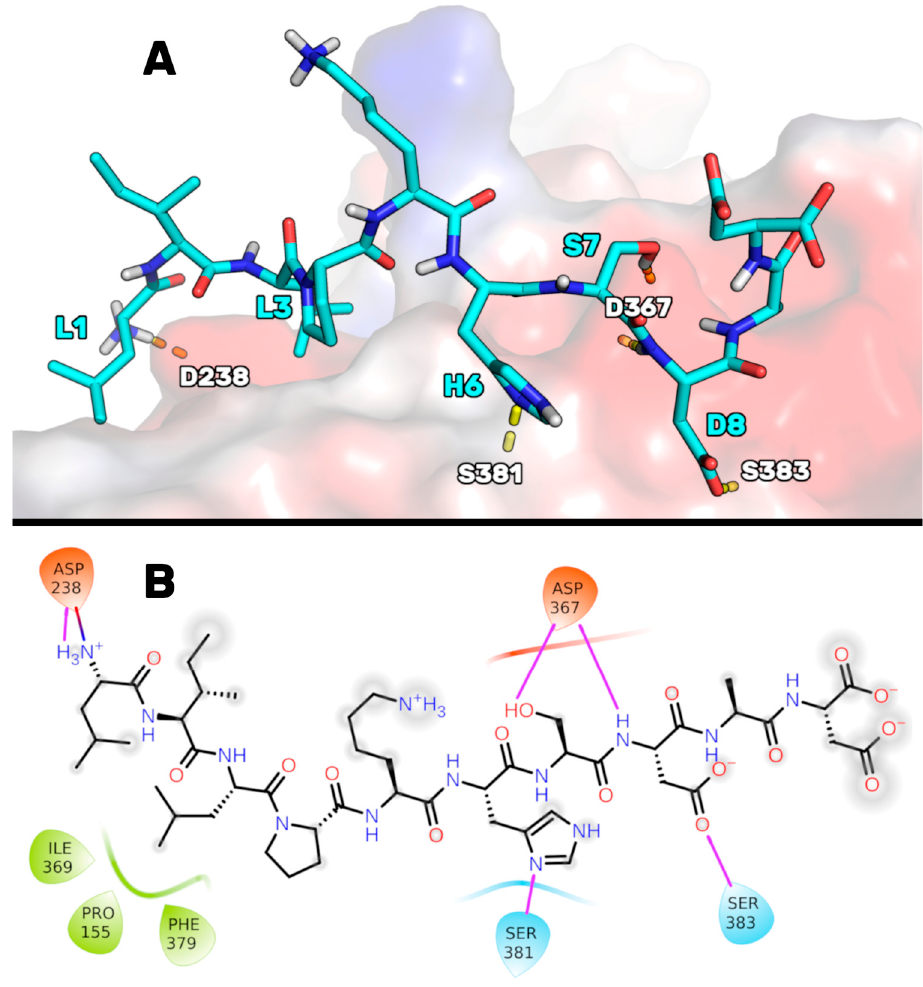
Figure 1. ( A ) The expected P5 binding mode on the PCSK9 surface after additional MD simulations. Yellow dotted lines highlight the H-bond network. The enzyme solvent-accessible surface is depicted accordingly by the partial charge of the residues: blue for positive areas and red for negative areas. Peptide P5 is represented as cyan sticks. ( B ) 2D representation of the predicted P5 binding mode in complex with PCSK9. H-bonds and salt bridges are highlighted in purple and blue/red lines, respectively. Hydrophobic residues interacting with P5 are colored in green.